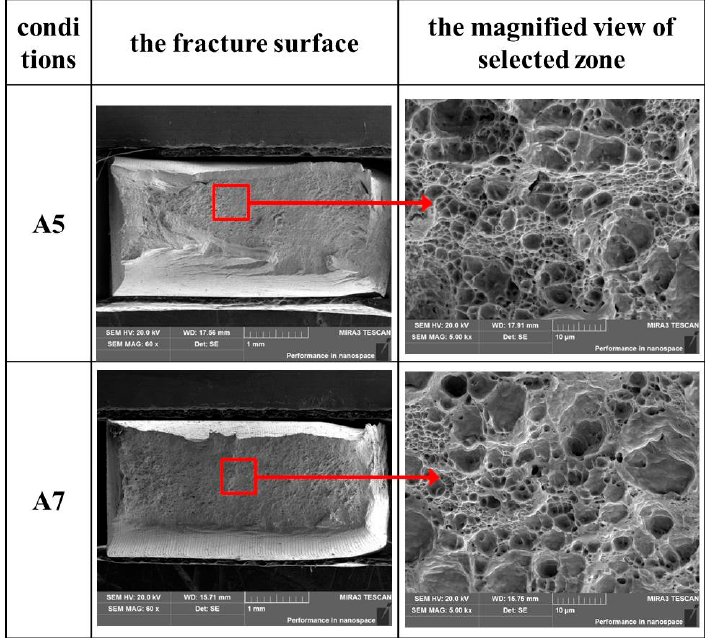
Figure 12. The SEM micrographs of the fracture surface of the dissimilar joints under conditions A5 and A7.